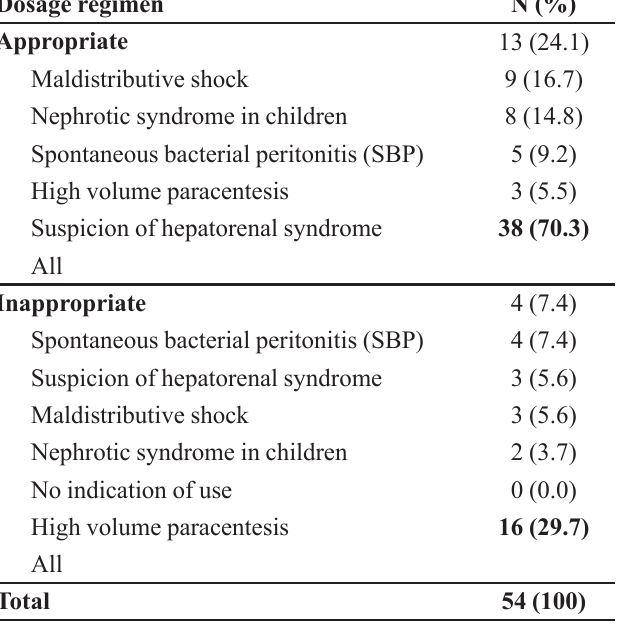
TABLE VII - Analysis of the appropriateness of therapeutic indications, according to other clinical protocols (HU-USP,